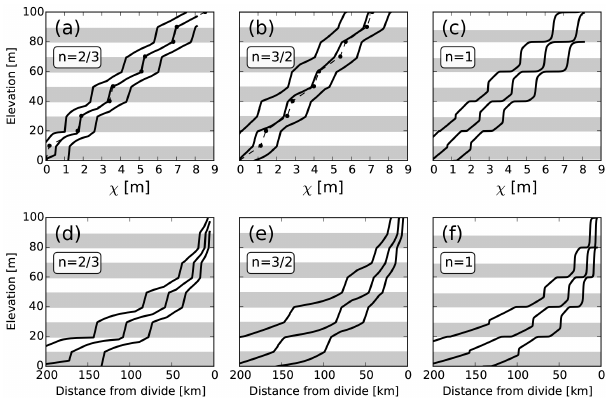
Figure 5. Channel profiles in subhorizontally layered rocks with low uplift (0.25mmyr − 1 ). (a–c) Channel profiles in χ -elevation space for cases where n = 2 / 3 (a) , n = 3 / 2 (b) , and n = 1 (c) . (d– f) Channel profiles as a function of distance from divide. Grey bands indicate weaker rocks. The low-uplift simulations utilize longer dis- tances and thinner rock layers in order to obtain a similar number of rock layer cycles. These profile shapes are qualitatively similar to the high-uplift cases (Fig.